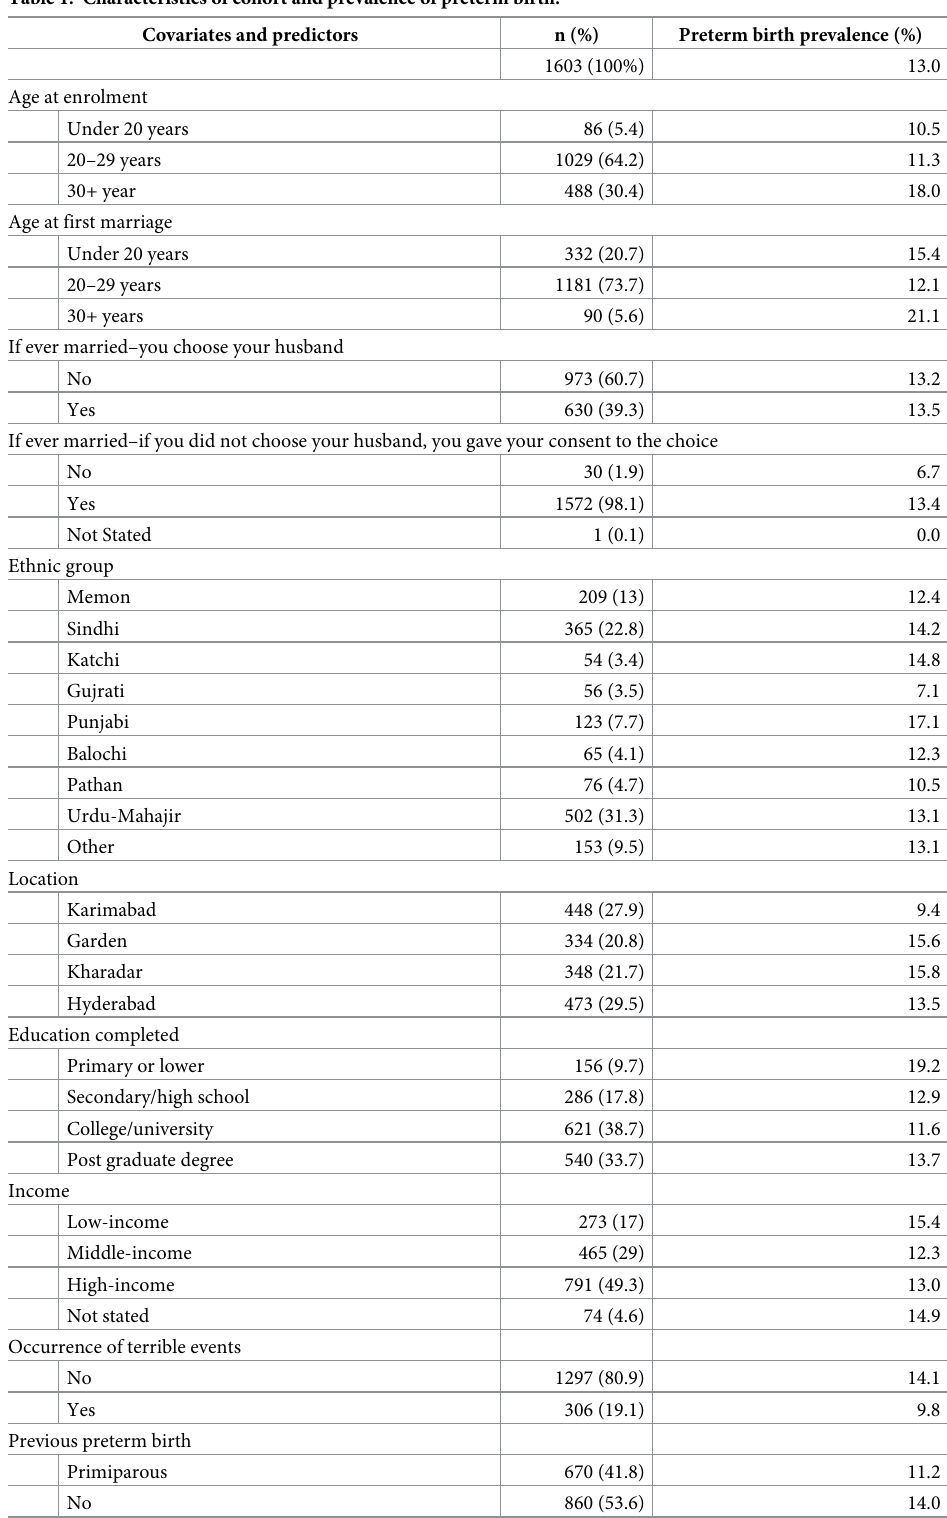
Table 1. Characteristics of cohort and prevalence of preterm